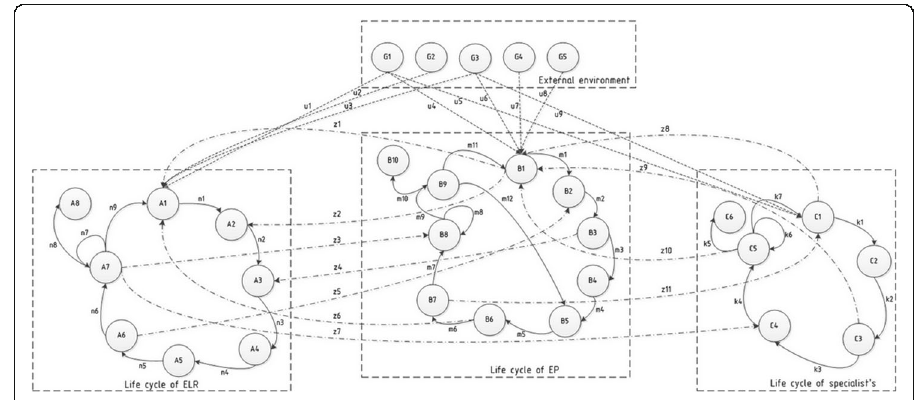
Fig. 4 The model of lifecycle